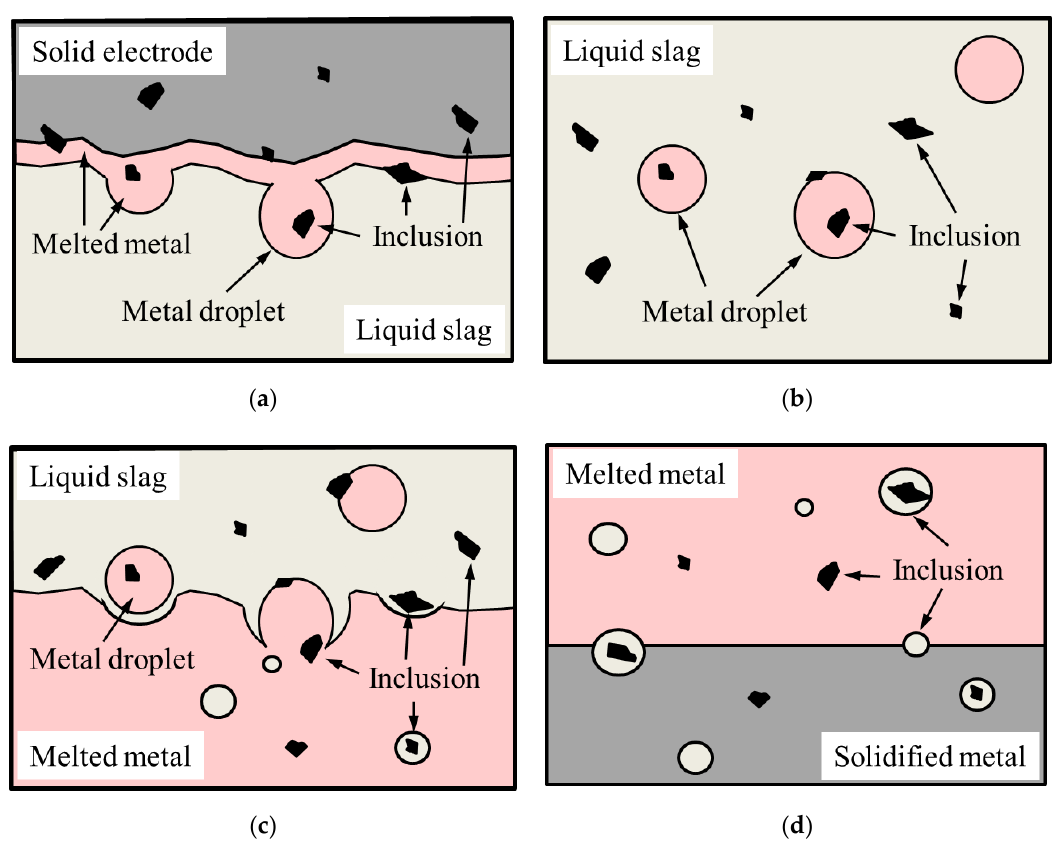
Figure 8. Schematic illustrations of different oxide inclusions in the melted metal layer on the surface of electrode, liquid slag, melted metal bath, and solidified ingot during the ESR process. ( a ) Solid electrode—Liquid slag; ( b ) Liquid slag; ( c ) Liquid slag—Melted metal bath; ( d ) Melted metal bath—Solidified ingot.